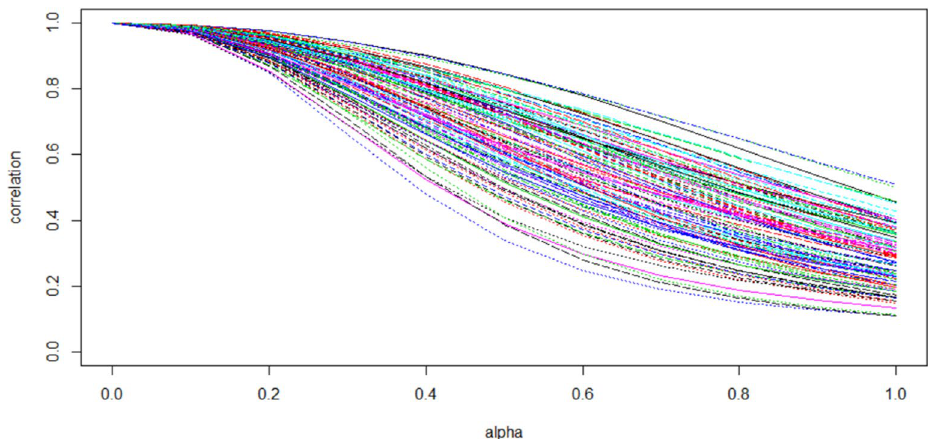
Figure 2. The correlations between 100 transformed gene expression profiles R − α X and their original versions X as α moves from 0 to 1. Each line of different color represents an mRNA. The features are 100 gene expression profiles selected from The Cancer Genome Atlas (TCGA) LIHC